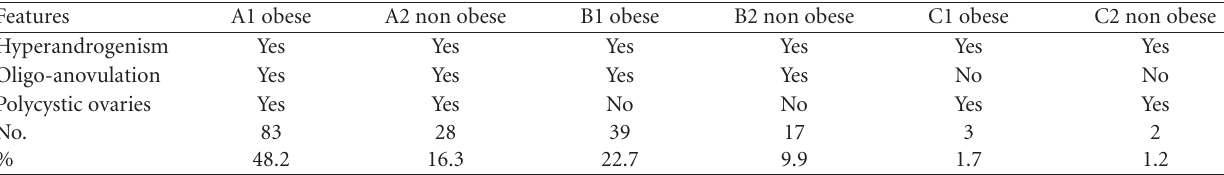
Table 2: Phenotype classification in 172 patients with polycystic ovary syndrome taking into account obesity.